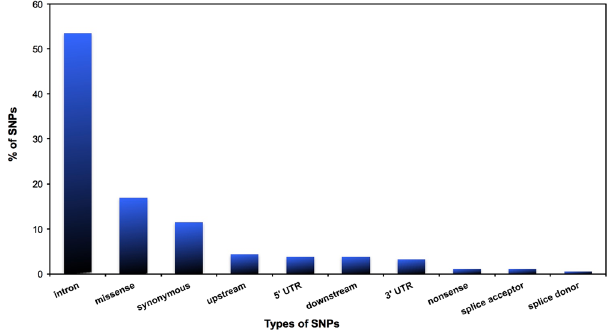
Figure 1. Distribution of SNPs within the APOE gene. The distribution was based on amino acid coding regions (missense, synonymous, nonsense, splice acceptor and splice donor) and on non-coding regions (intronic, upstream and downstream). It can be seen that the majority of the SNPs occur in non-coding regions: 53.6% in introns, 4.4% in upstream regions, 3.8% in 5 ′ UTR, 3.8% downstream and 3.3% in 3 ′ UTR. In the coding regions, the majority of the SNPs are missense (16.9%), followed by synonymous (11.5%), nonsense (1.1%), splice acceptor (1.1%) and splice donor (0.6%)